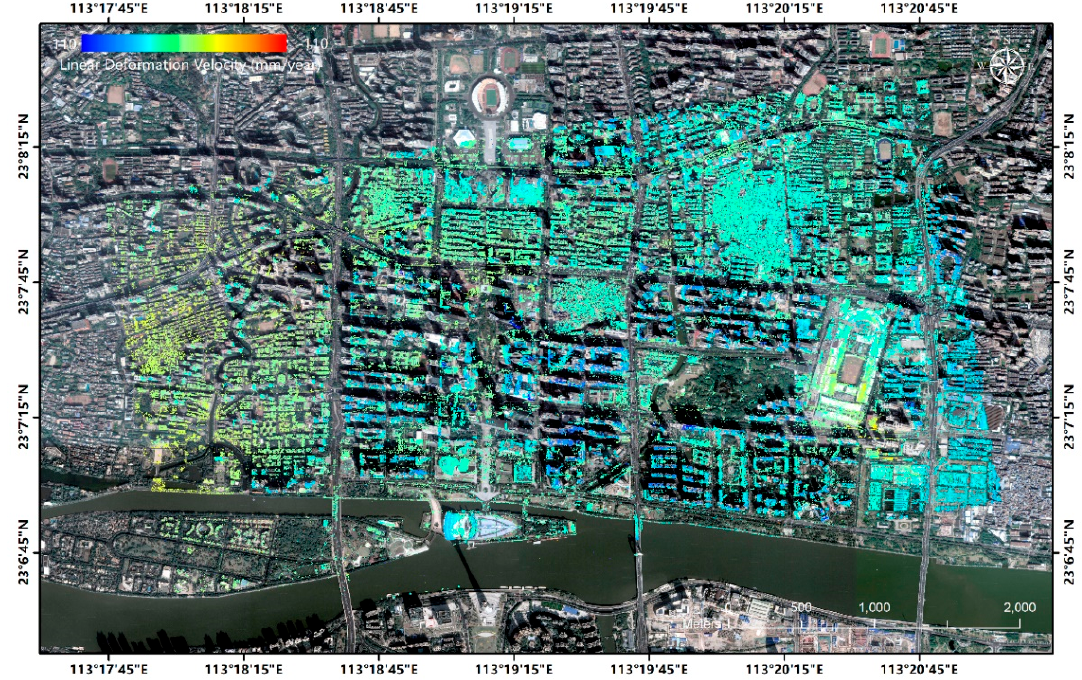
Figure 13. Linear deformation map generated from the proposed processing results, using PS points with a temporal coherence of larger than 0.85.